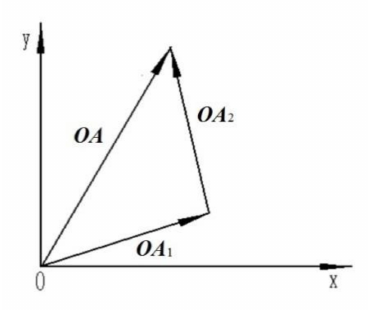
Figure 11. Vector sum